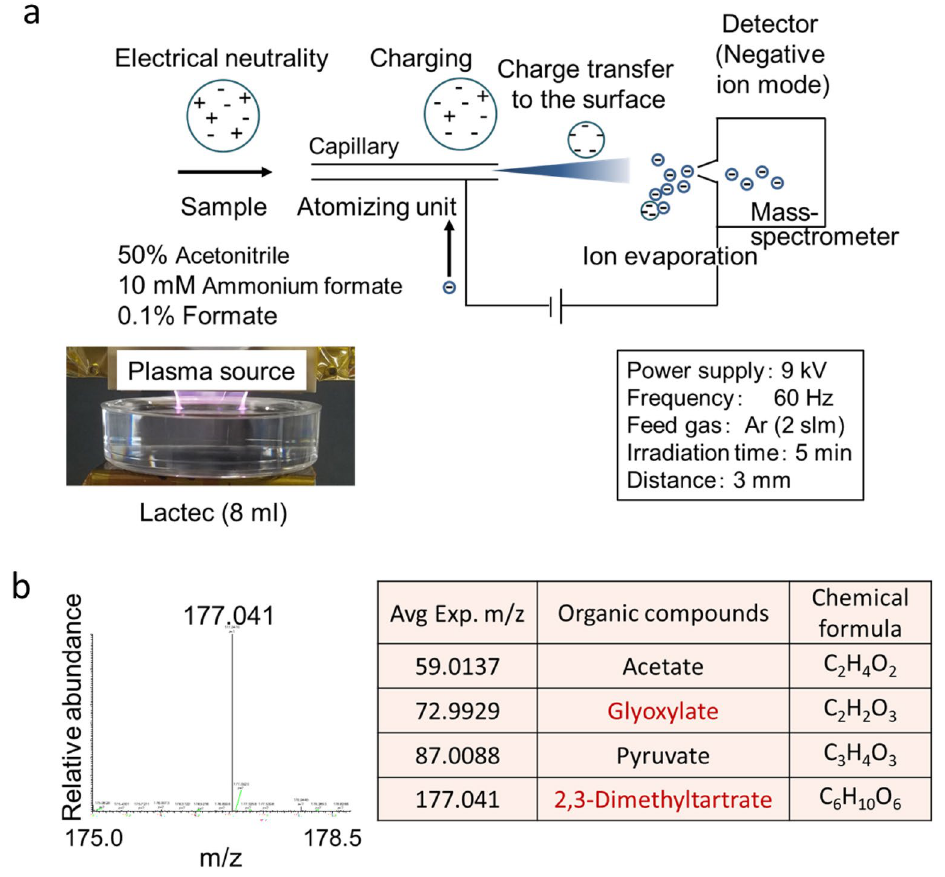
Figure 3. Direct infusion-ESI–MS/MS analysis of PAL. ( a ) Schematic of the direct infusion-ESI–MS/ MS analysis of PAL. ( b ) Acetate ( m/z 59.0137), glyoxylate ( m/z 72.9929), pyruvate ( m/z 87.0088), and 2,3-dimethyltartrate ( m/z 177.041) were identified in PAL. Lactec: Ringer’s lactate